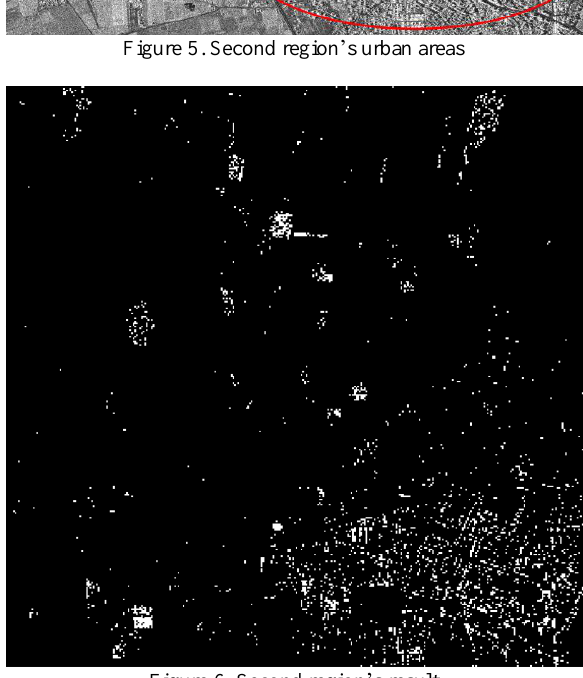
Figure 6. Second region’s